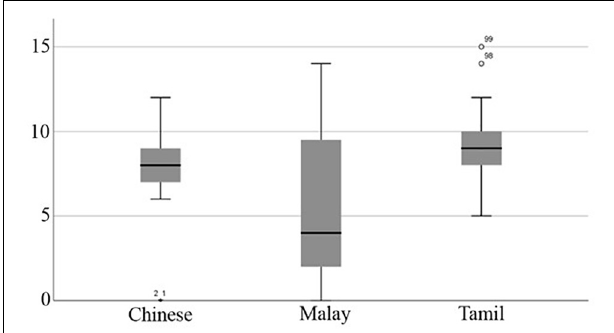
FIGURE 1 | Total number of errors committed by Chinese, Malay, and Tamil Asian language groups in subsample matched for SES ( N = 120).